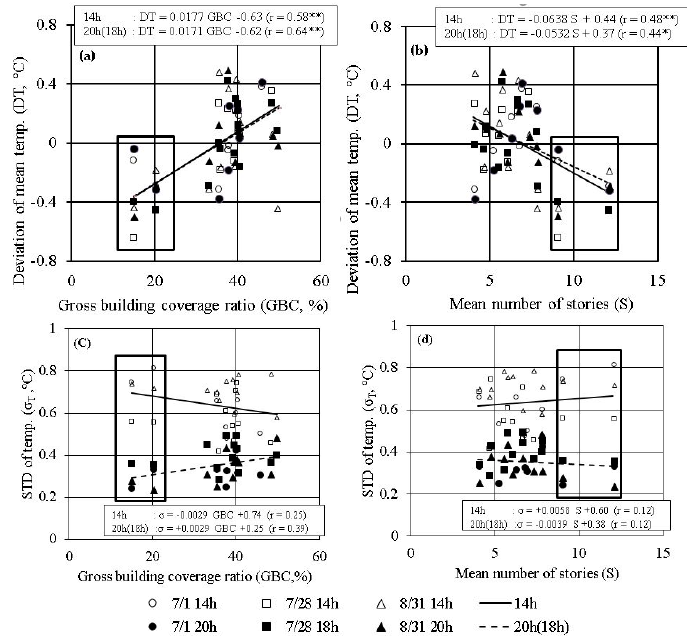
Figure 8. Relationships between ( a ) gross building coverage ratio (GBC) and deviation of mean temperature (DT), ( b ) the mean number of stories (S) and DT, ( c ) GBC and standard deviation of temperature in a subarea ( σ T ), and ( d ) S and σ T . The symbols in a box of thick line are the data within the Nakanoshima district (subarea 7 and 8). **: p < 0.01, *: p < 0.05.